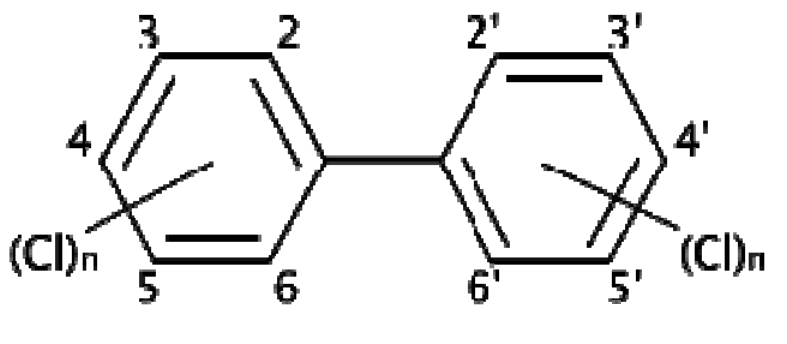
Figure 1. Polychlorinated biphenyls